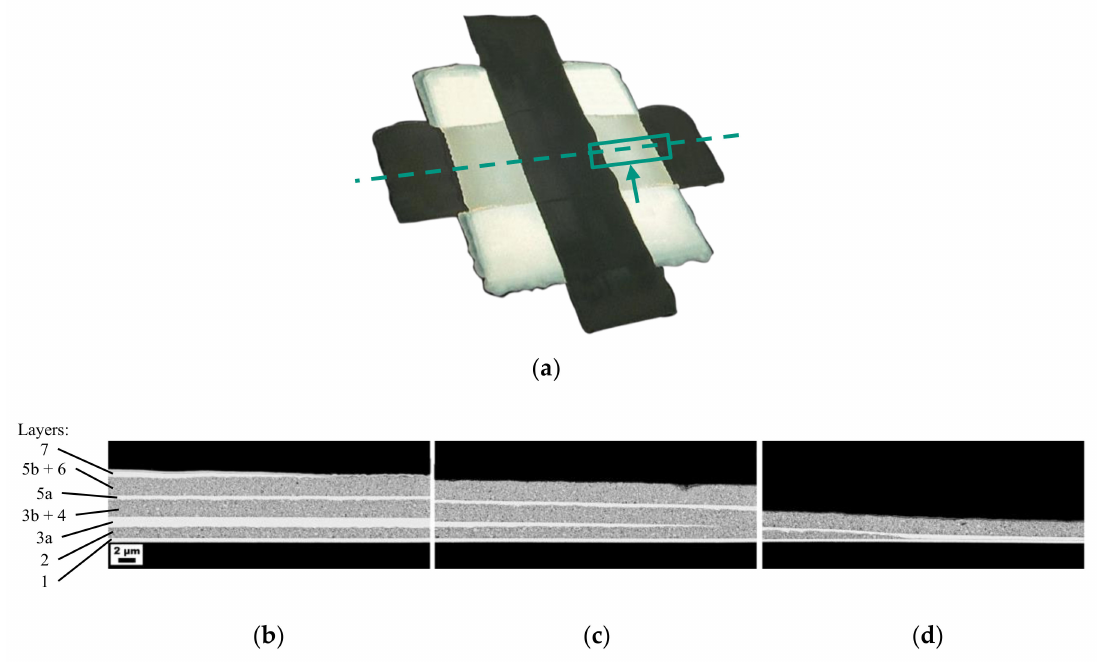
Figure 5. ( a ) Microscope image in which the dashed line shows the cut made to prepare the SEM images. The rectangle represents the area shown in the following cross-sectional SEM images, and the arrow shows the viewing direction; ( b – d ) SEM images of the area shown in (a) with the same labeling as in Figure 1. (1) First electrode; (2) First dielectric layer; (3a) Second electrode; (3b) Supporting structure; (4) Second dielectric layer; (5a) Third electrode; (5b) Supporting structure; (6) Third dielectric layer; (7) Fourth